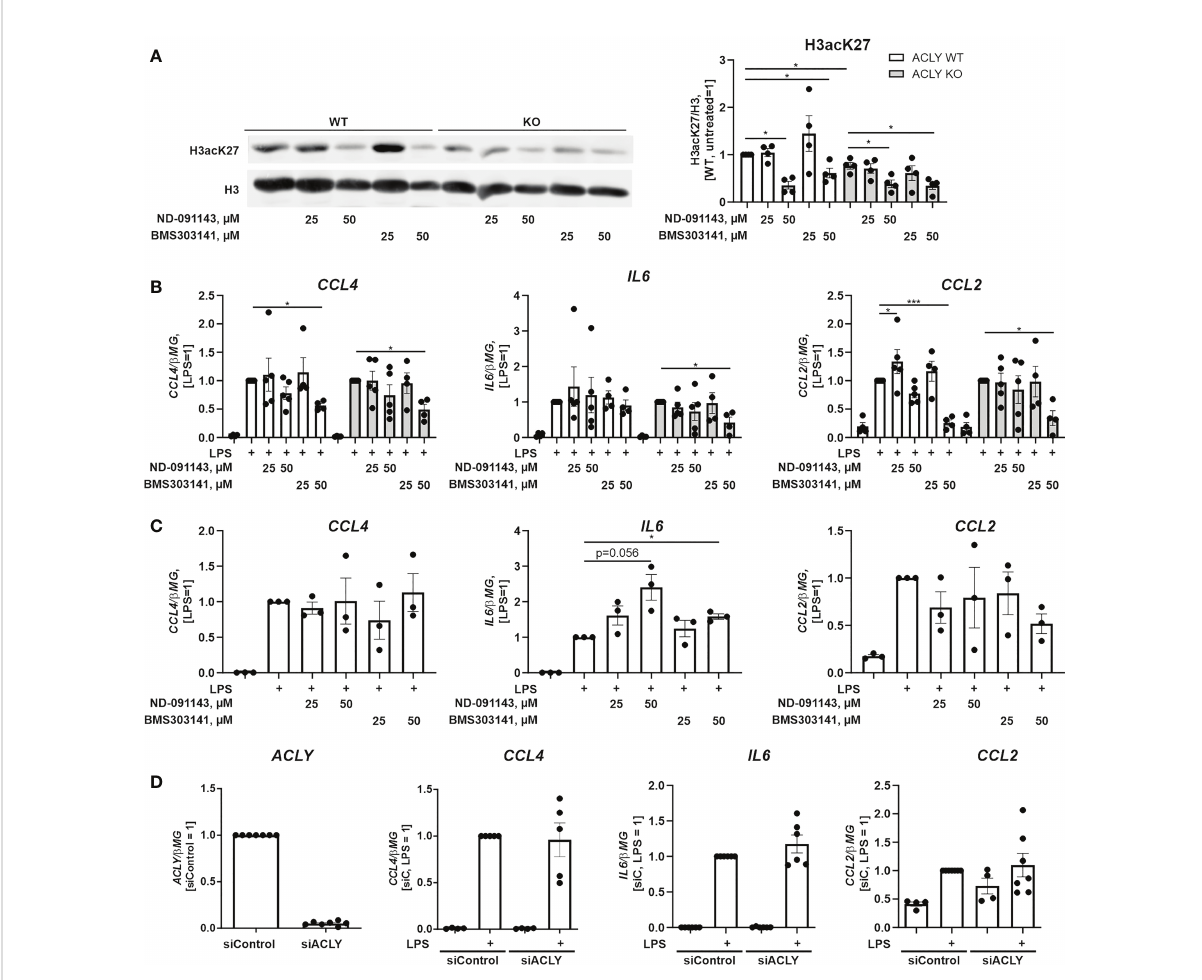
FIGURE 4 Pharmacological ACLY inhibition or ACLY silencing do not recapitulate pro-in fl ammatory phenotype of ACLY knockout. (A) Western blot analysis of histone H3 acetylation at K27 in ACLY WT and knockout THP-1 cells upon treatments with 25 and 50 m M ND-091143 or BMS303141 for 24 hours. (B) mRNA expression of IL6, CCL2 and CCL4 in ACLY WT and knockout THP-1 cells treated with 25 and 50 m M ND-091143 or BMS303141 for 24 hours and 100 ng/ml LPS for 3 hours. (C) mRNA expression of IL6, CCL2 and CCL4 in human macrophages treated with 25 and 50 m M ND-091143 or BMS303141 for 24 hours and 100 ng/ml LPS for 3 hours. (D) mRNA expression of ACLY, IL6, CCL2 and CCL4 in human macrophages transfected with control (siControl) or ACLY siRNA for 96 hours prior to treatment with 100 ng/ml LPS for 3 hours. Data represent mean values ± SE of 3-4 independent experiments. * p<0.05, ***